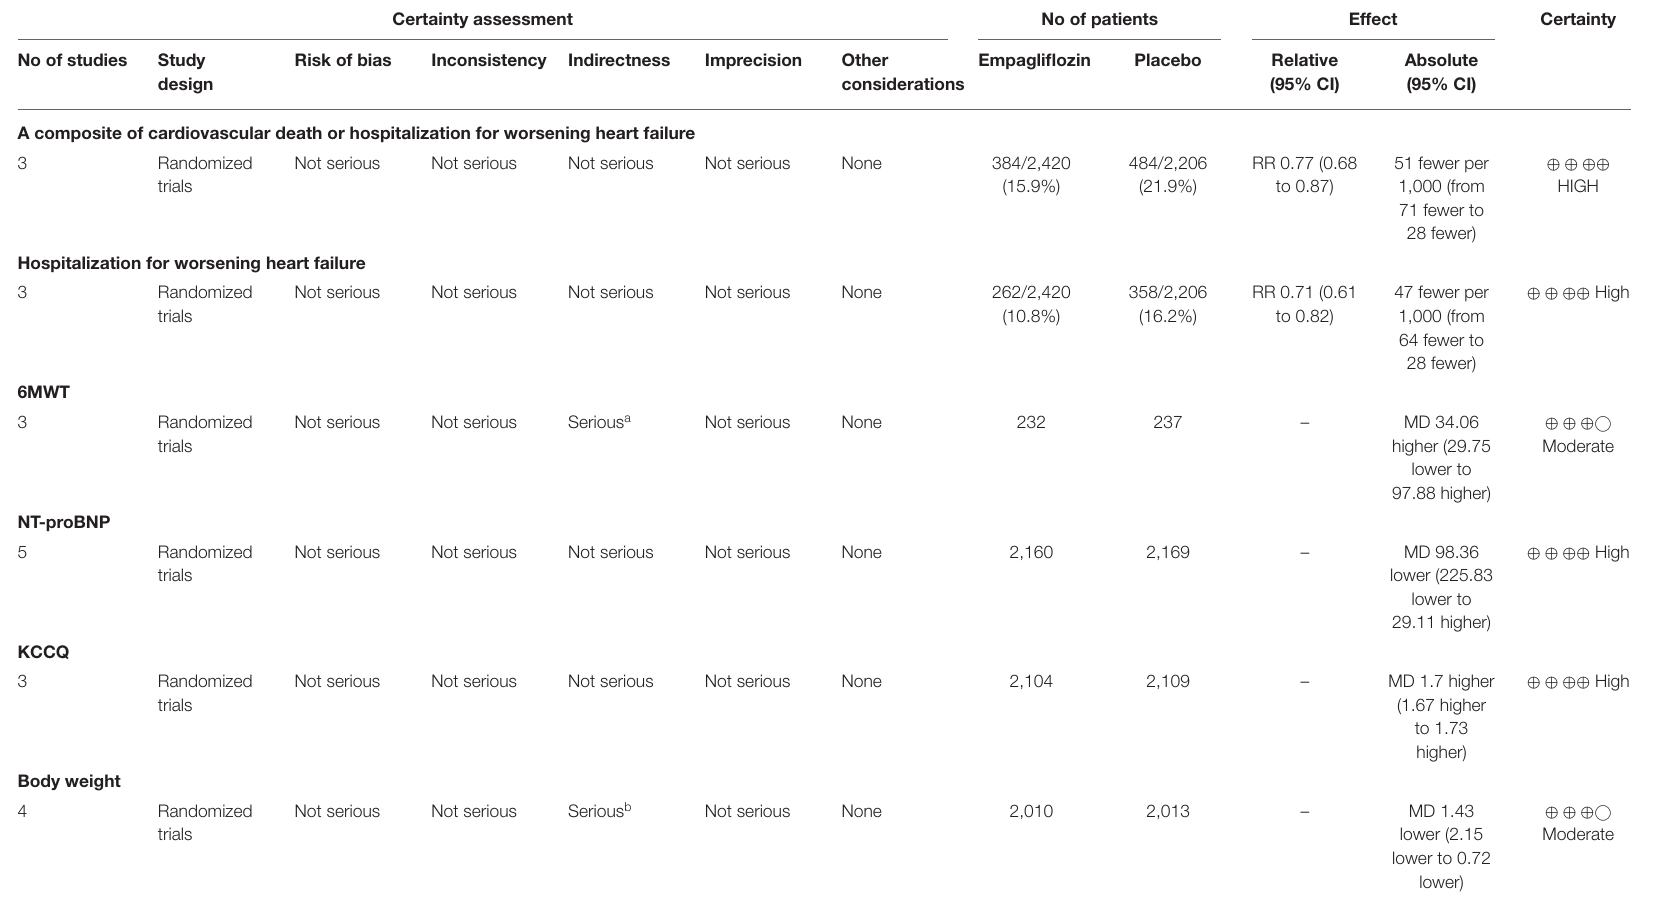
TABLE 2 | Grading of Recommendations Assessment, Development, and Evaluation (GRADE)